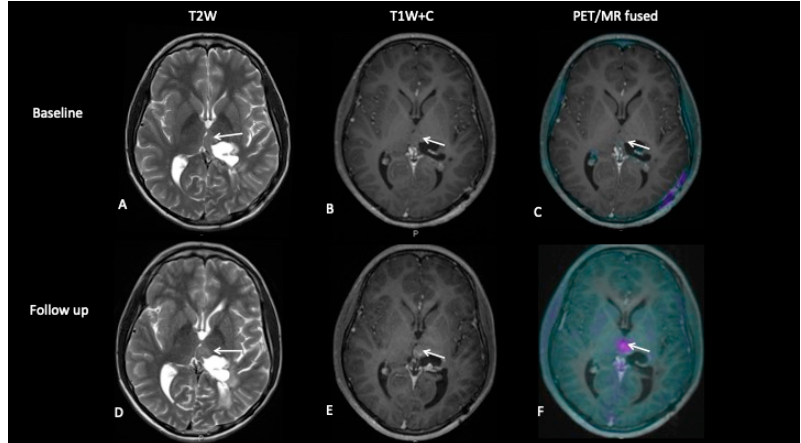
Figure 6. Baseline imaging demonstrates large pontine tumour ( A ) with focus of enhancement ( B ). tumour progression, but FDOPA ( E ) did not show increased uptake (white arrow) and was suggestive of pseudoprogression. However, FDOPA did show increased avidity in the left cerebellar hemisphere (red arrow) confirming non-enhancing tumour progression at that